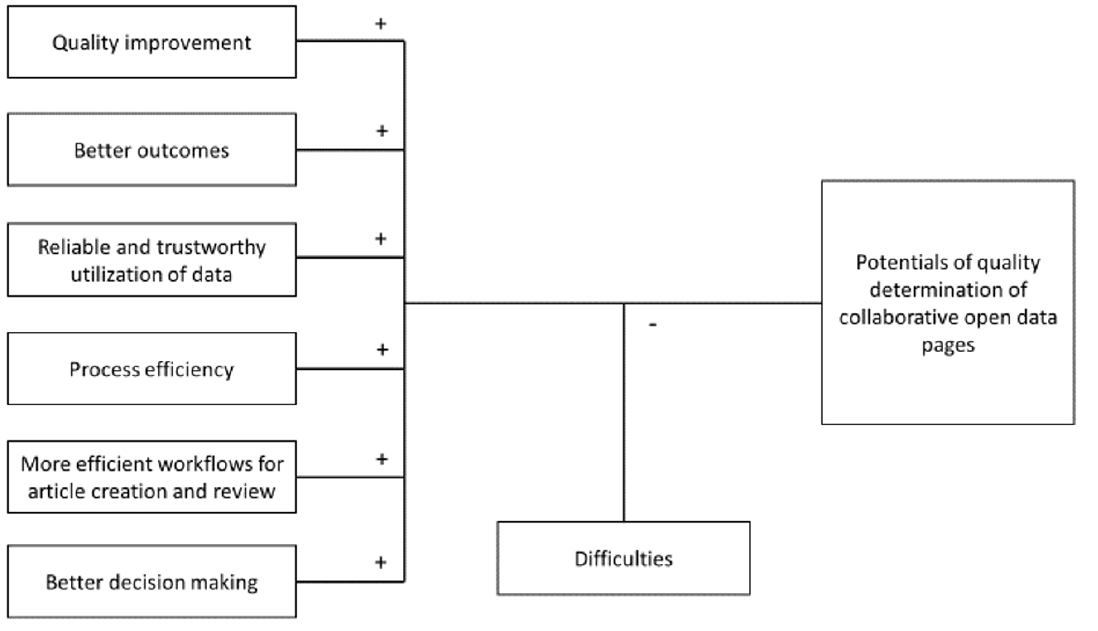
Figure 1. Designed